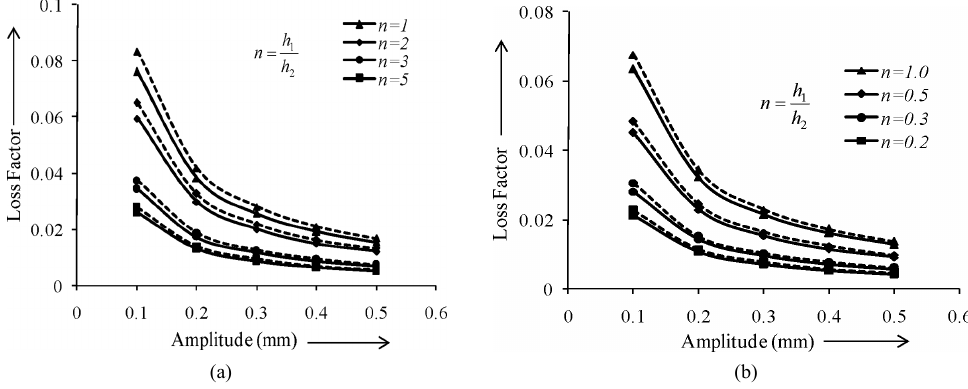
Fig. 10. Surface plot of static de fl ection of the welded beam with axial position and thickness ratio less than one.